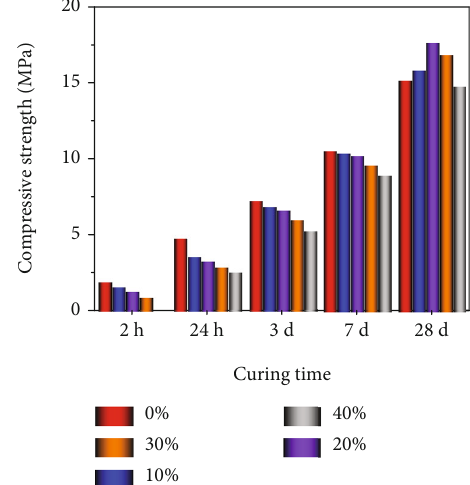
Figure 2: Relationship between slurry stone compressive strength and fl y ash